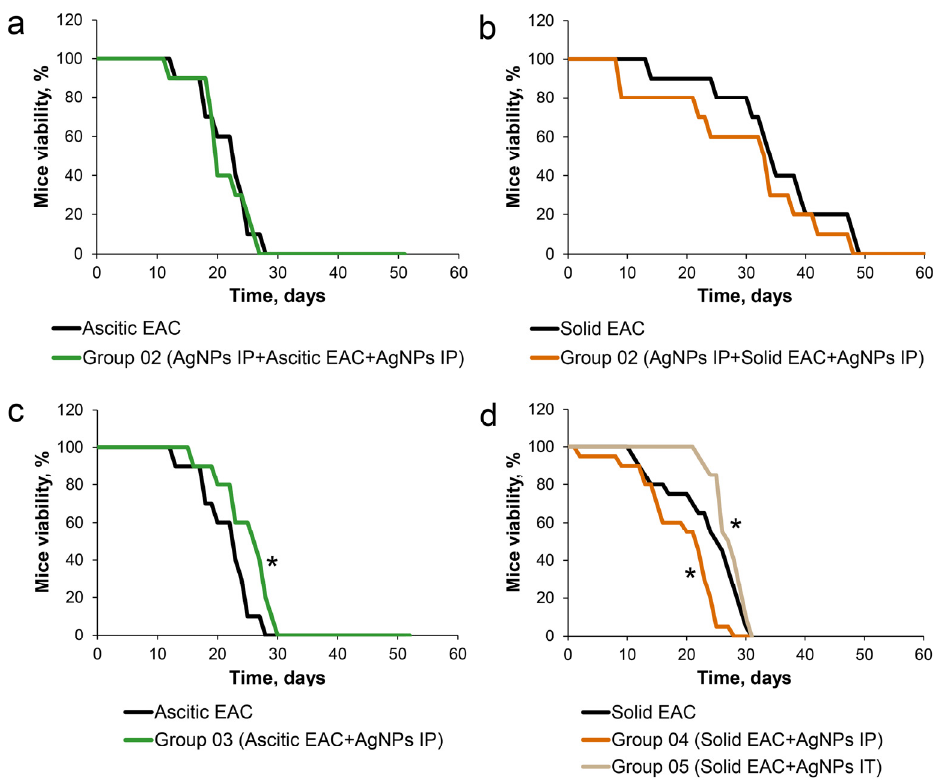
Figure 5. Survival curves of mice bearing ascitic EAC ( a , c ) or solid EAC ( b , d ) treated with AgNPs. ( a ) Mice received AgNPs IP prior to IP inoculation of EAC cells; treatment with nanoparticles continued after tumor injection till the end of the experiment (mice of group 02 with ascitic EAC in Figure 4). ( b ) Mice received AgNPs IP prior to IT inoculation with EAC cells, treatment with nanoparticles continued after tumor injection until the end of the experiment (mice of group 02 with solid EAC in Figure 4). ( c ): Mice received AgNPs IP simultaneously with inoculation of EAC cells began to receive IP AgNPs; ( d ) Mice received AgNPs IP (brown) or IT (beige) simultaneously with EAC cell inoculation. IP inoculation: 1 × 10 6 EAC cells were injected intraperitoneally; IT inoculation: 1 × 10 6 EAC cells were injected in the right thigh. IP treatment with AgNPs: intraperitoneally 100 µL of 3.5 mM AgNPs’ solution per mice; IT treatment with AgNPs: inside growing tumors 10 µL of 3.5 mM AgNPs’ solution per mice. Observation was carried out until all the animals died ( n = 18). *: p < 0.5.